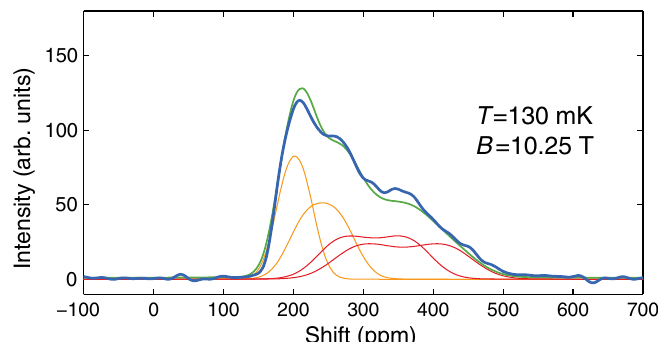
Figure 8. Color online. Example of spectrum simulation compared to recorded spectrum (blue) from FIG. 5. Example of spectrum simulation in the FFLO state, Koutroulakis et al. [12]. The simulation is a sum (green) of four Gaussian-broadened contributions compared to recorded spectrum (blue). The simulation is a sum (red, orange) arising from a single-Q sinusoidal modulation of the SC order (green) of four Gaussian-broadened contributions (red, orange) arising from a single- Q sinusoidal modulation of the SC order parameter [21].